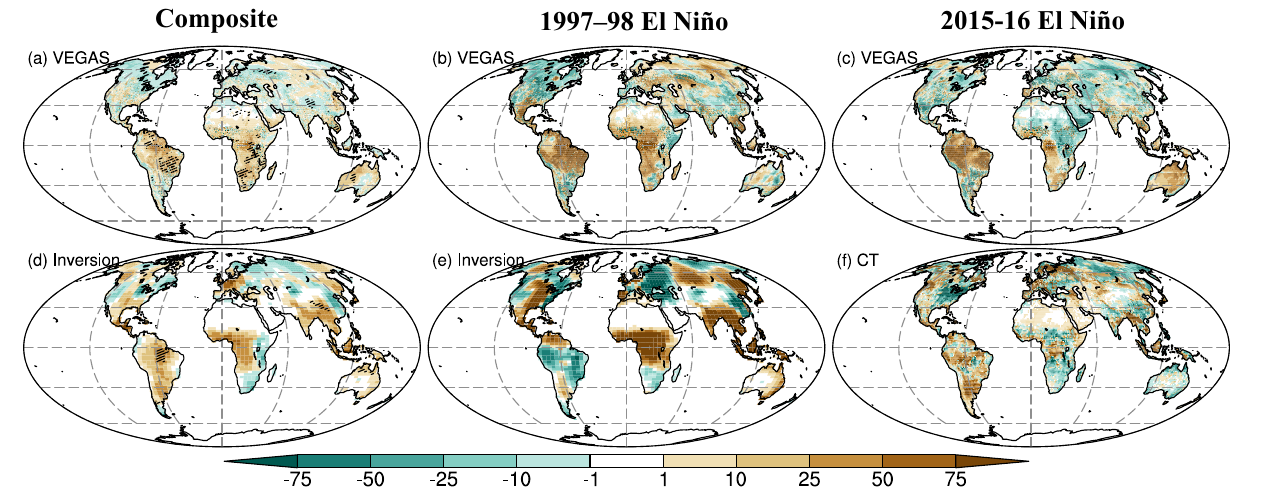
Figure 5. Spatial F TA anomalies calculated from July in the El Niño developing year to October in the El Niño decaying year (units: gCm − 2 yr − 1 ). (a–c) Results of the composite, 1997/98, and 2015/16 El Niño events simulated by VEGAS, respectively. (d–e) The averaged results of CAMS and MACC in the composite and 1997/98 El Niños. (f) The 2015/16 El Niño F TA anomaly in CarbonTracker. The stippled areas in (a) and (d) are significant above the 90% level, estimated by Student’s t